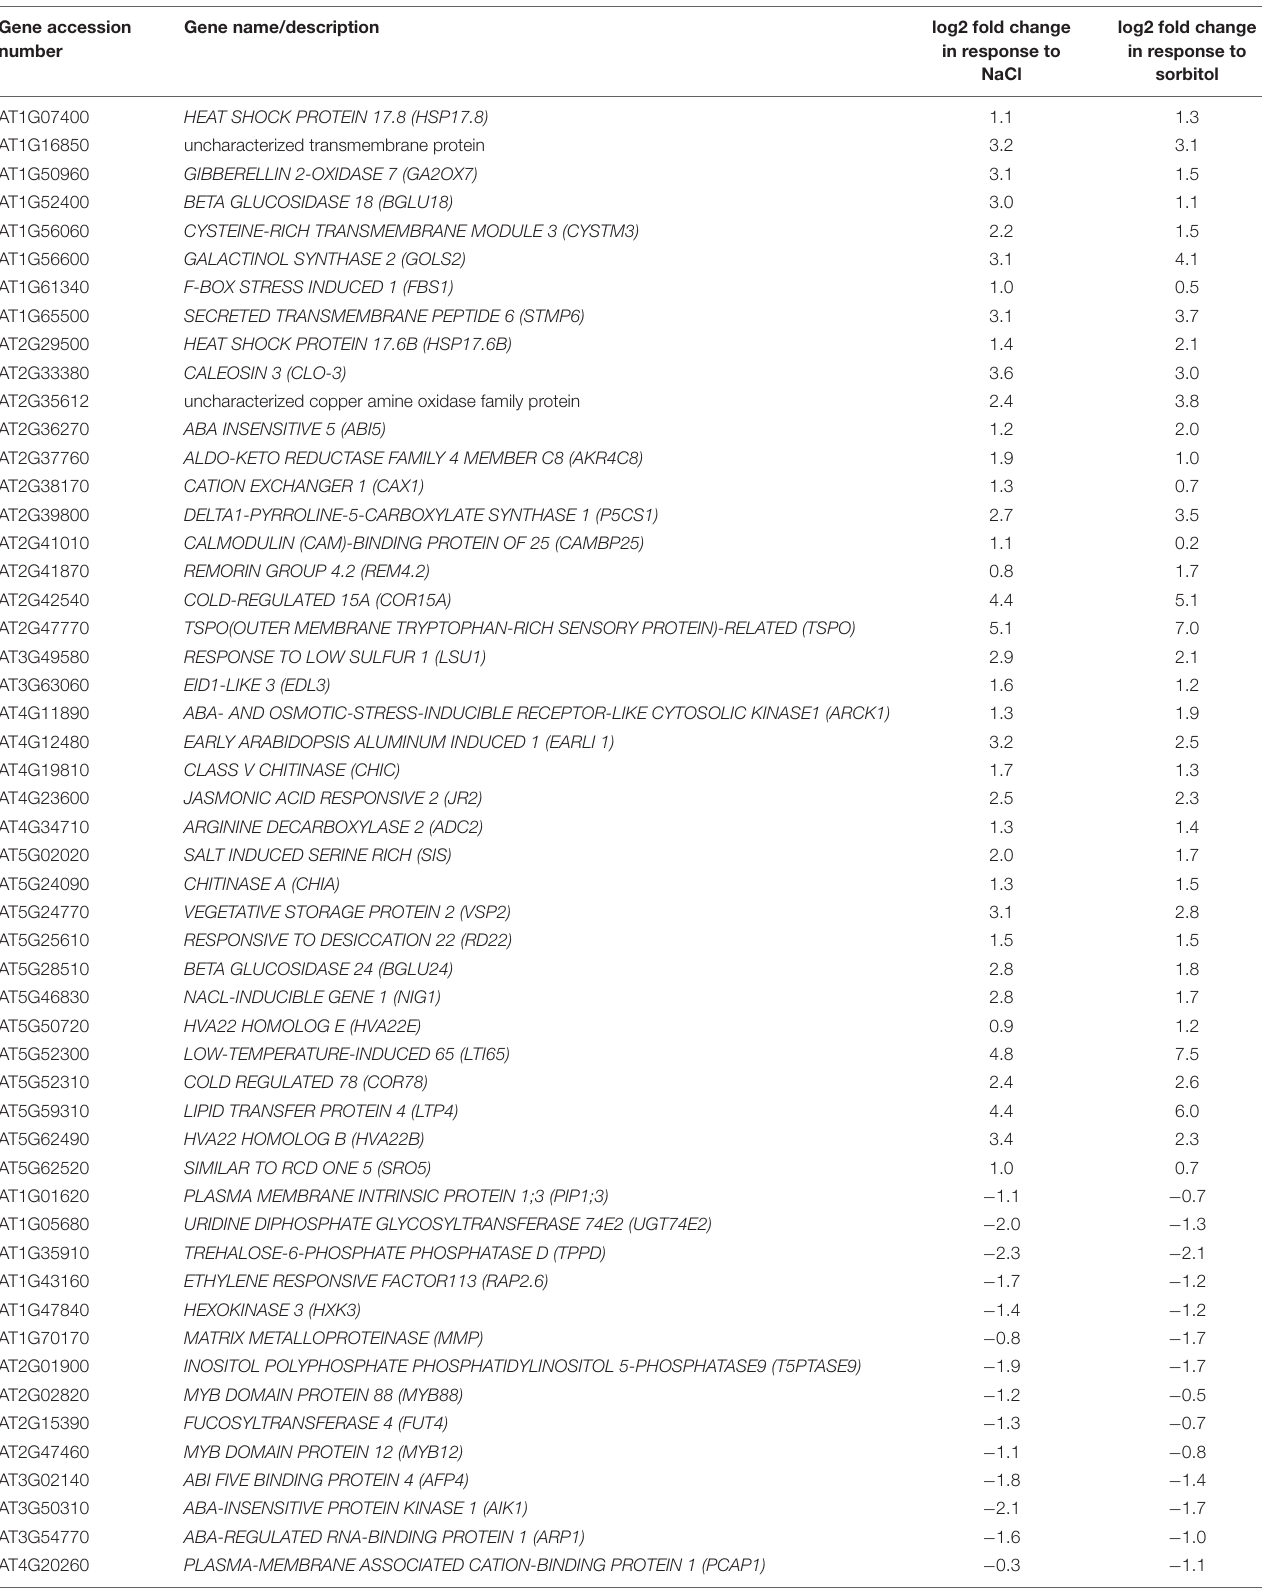
TABLE 2 | The genes from the osmotic gene list annotated with the enriched GO term “response to salt